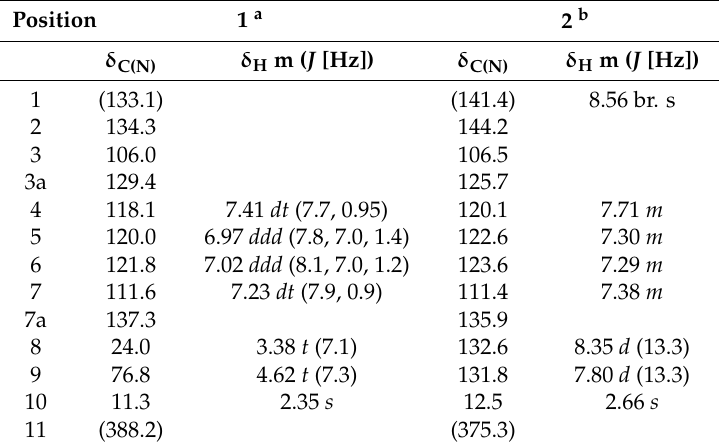
Table 1. 1 H, 13 C, and 15 N-NMR spectral data of Labindoles A ( 1 ) and B ( 2 ).